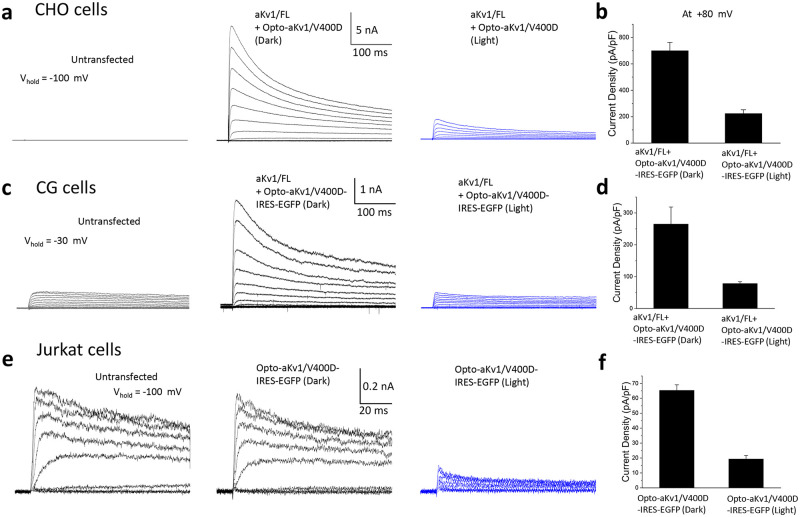
Photoactivation of dominant negative Opto-aKv1/V400D subunits in mammalian cells, cerebellar granule cells, and Jurkat cells.a) Photoactivation of Opto-aKv1/V400D markedly suppresses wild-type aKv1/FL current in CHO-K1 cells. CHO-K1 cells were co-transfected with wild-type aKv1/FL and Opto-aKv1/V400D, allowed to express overnight, and were either left in the dark or exposed to blue light for 1.5 hours before recordings. Whole-cell currents were elicited by step depolarization from -90 to +80 mV from a holding potential of -80 mV. b) Current density at +80 mV under dark and blue light conditions. Data is shown as mean ± SEM. Number of experiments: n = 12 for dark and n = 7 for blue light. c) Photoactivation of Opto-aKv1/V400D heterologously expressed in cerebellar granule (CG) cells also suppresses wild-type aKv1/FL current. To isolate the aKv1/FL current, the prominent endogenous Kv4 subthreshold A-current (ISA) was inactivated by a 900 ms-long prepulse to -30 mV before the test pulse to various potentials between +80 mV and -90 mV in 10 mV increments. Light treatment was the same as in A. d) Current density at +80 mV under dark (n = 8) and blue light (n = 4). e) Suppression of endogenous Kv1.3 in Jurkat cells by photoactivation of heterologously expressed Opto-aKv1/V400D channels. f) Current density of Kv1.3 current in Jurkat cells expressing Opto-aKv1/V400D in the dark (n = 4) and blue light (n = 5) (p < 0.01). Data is shown as mean ± SEM.